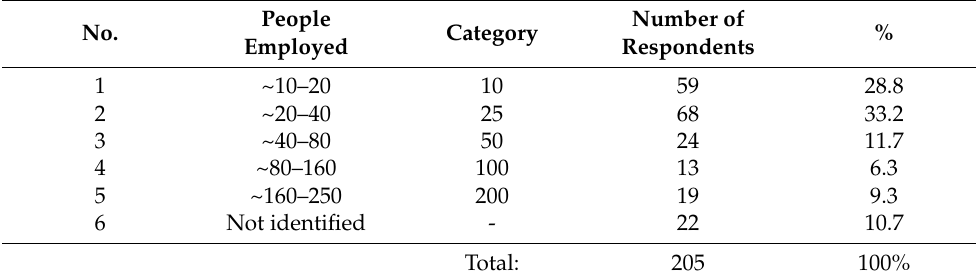
Table 3. The distribution of respondents by company size (n = 205).